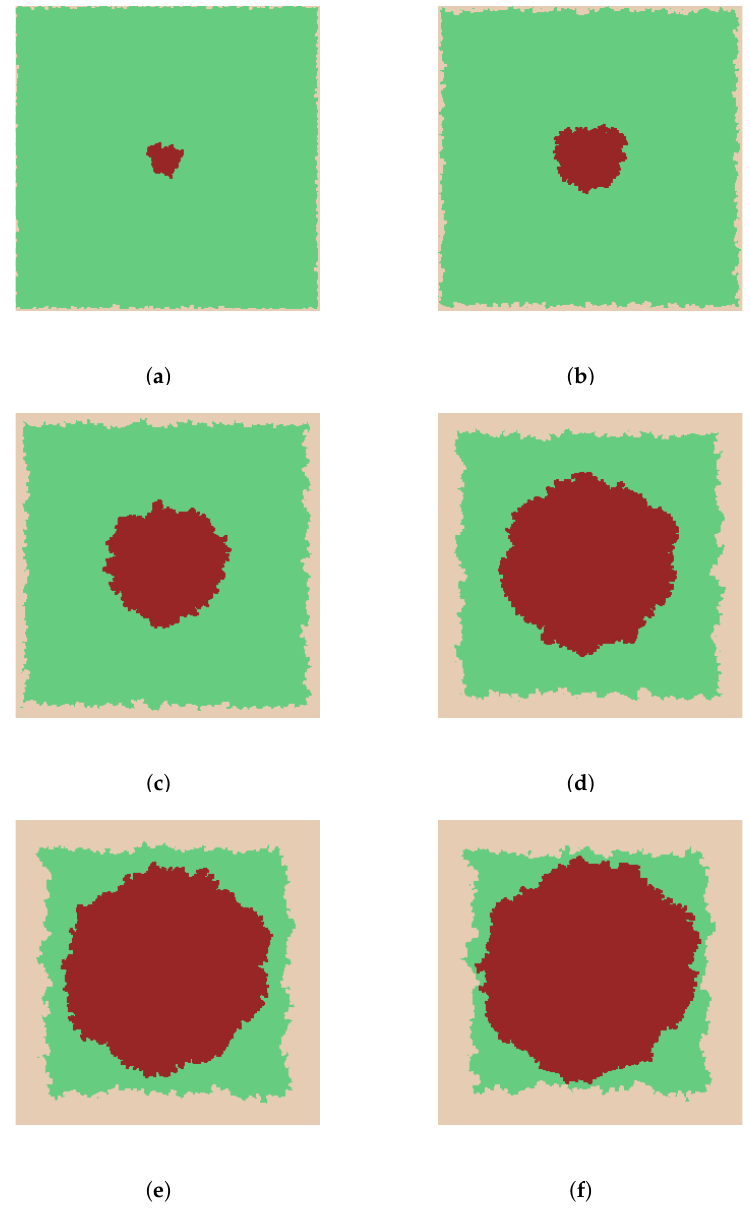
Figure 5. Eden model simulation of epithelialization and bacteria infection for a square skin wound. is wound space, is epithelialization, and is bacteria growth. The progression of epithelialization showing wound contraction, and bacteria growth showing the scale of infection, are given. Compared to the initial wound, re-epithelialization and bacteria burden at the different stages are approximately ( a ) 3% and 1% ; ( b ) 7% and 4%; ( c ) 15% and 12%; ( d ) 28% and 25%; ( e ) 37% and 35%; and ( f ) 41% and 39%. The stage ( f ) represents a stall chronic wound. The epithelialization and bacteria growth rates are